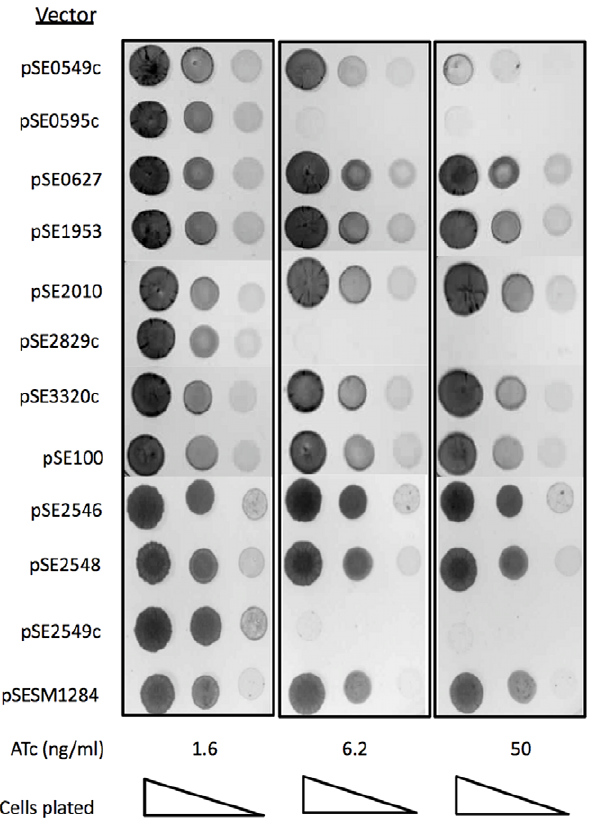
Figure 1. Effect of mycobacterial VapC expression on growth of M.smegmatis on solid media. Ten-fold serial dilutions of cells were spotted on 7H10 agar without or with ATc (1.6, 6.2 and 50 ng/ml) and incubated for 24–48 h.